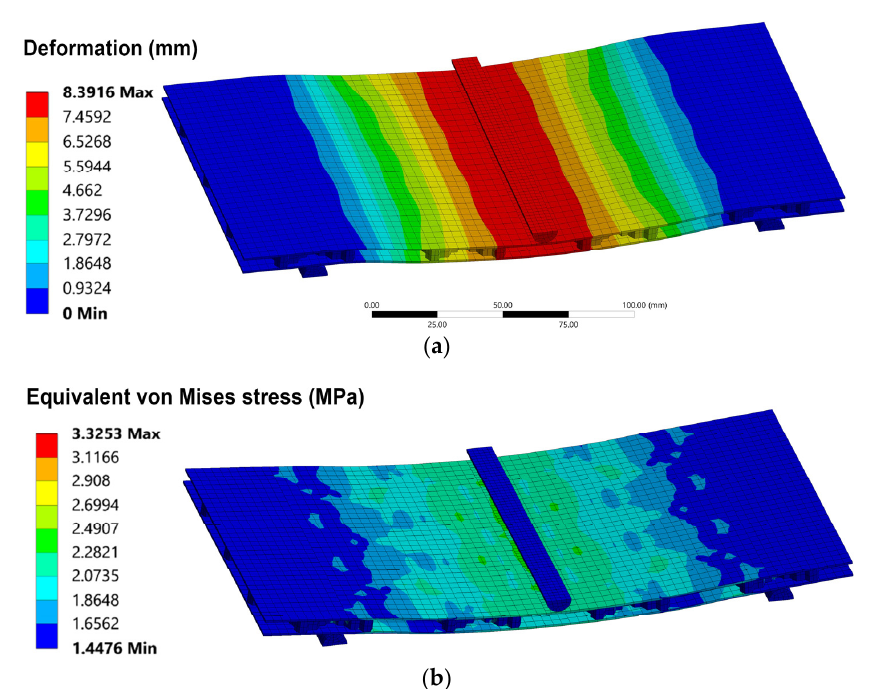
Figure 8. ( a ) Deformation and ( b ) equivalent von Mises stresses for the second level of hierarchical sandwich specimens under bending load.